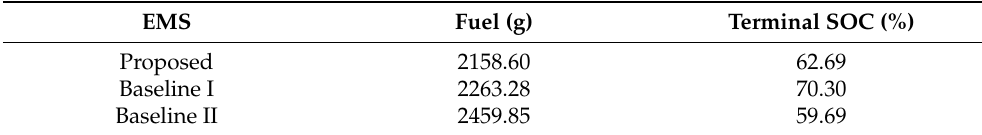
Figure 8. Fluctuation of the fuel consumption ( a ) and battery SOC ( b ) of different strategies under different testing conditions. Table 6. Comparison among various EMSs in the testing conditions.